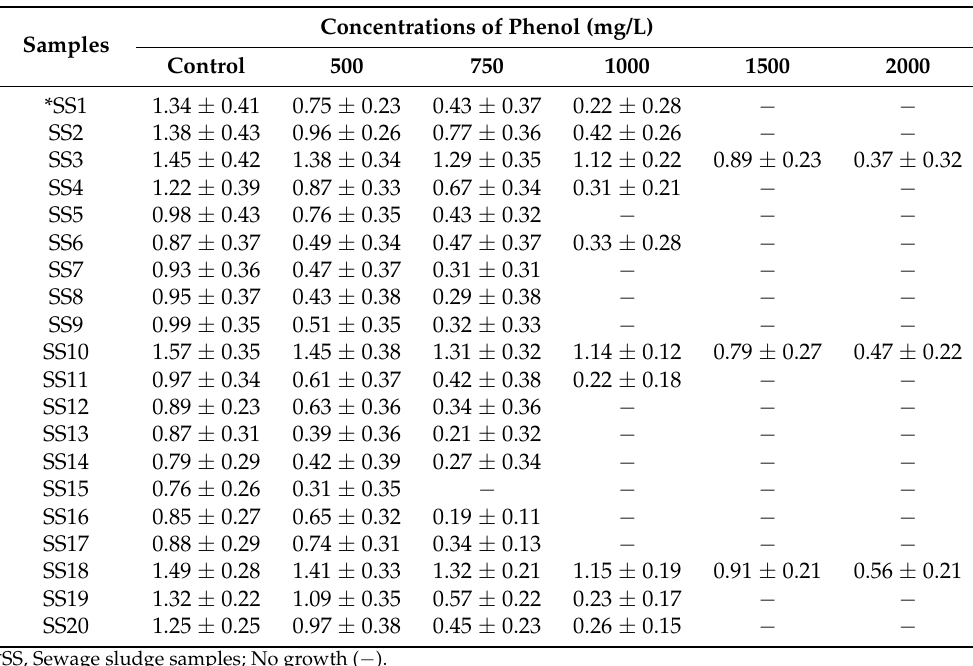
Table 1. Bacterial populations (OD600 ± SD) from sewage sludge (SS) can grow on MSM supple- mented with different concentrations of phenol (500 to 2000 mg/L).